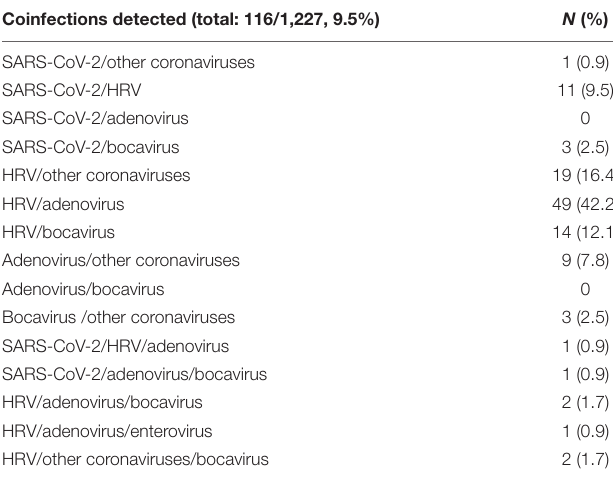
TABLE 4 | Coinfections